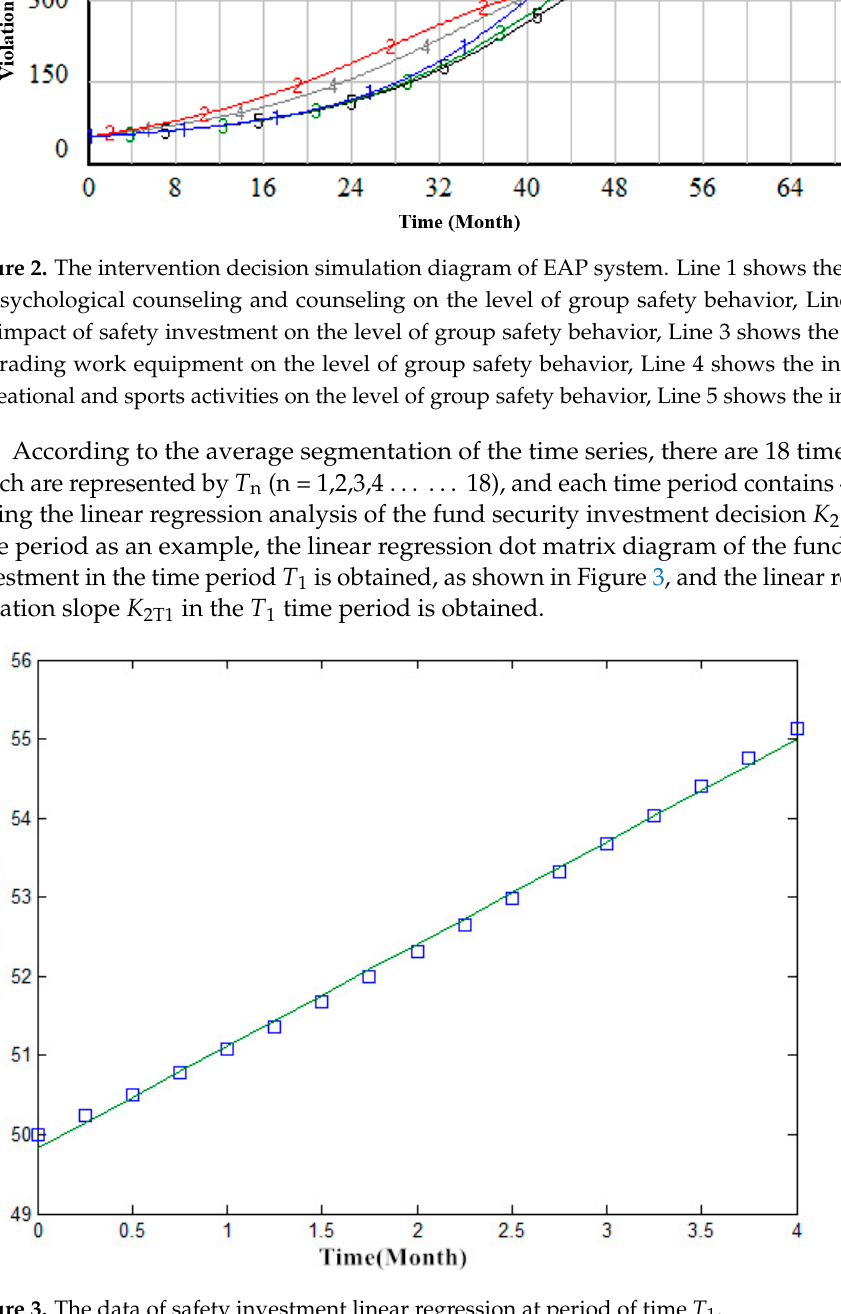
Figure 3. The data of safety investment linear regression at period of time T 1 . According to the above method, the four decisions of the EAP system in each time period are analyzed and researched, and the growth rate K of the EAP system in each time period after each decision-making strength is strengthened is shown in Table 2. The comparison of the slope Kn and the original data K 0 after the various decision-making efforts are strengthened is shown in Figure